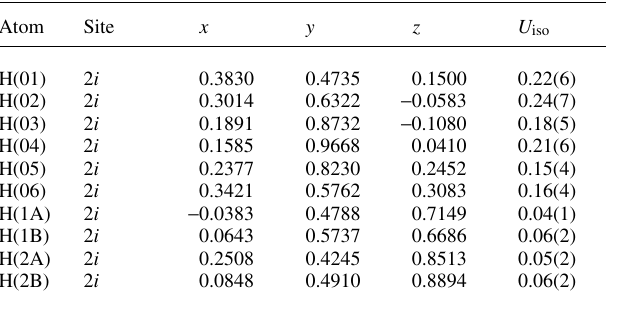
Table 5. Atomic coordinates and displacement parameters (in Å 2 )